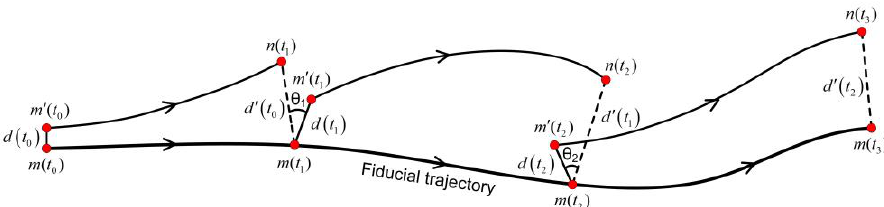
Figure 3. Schematic of evolution and replacement procedure of neighbor points when calculating the largest Lyapunov exponent by Wolf.